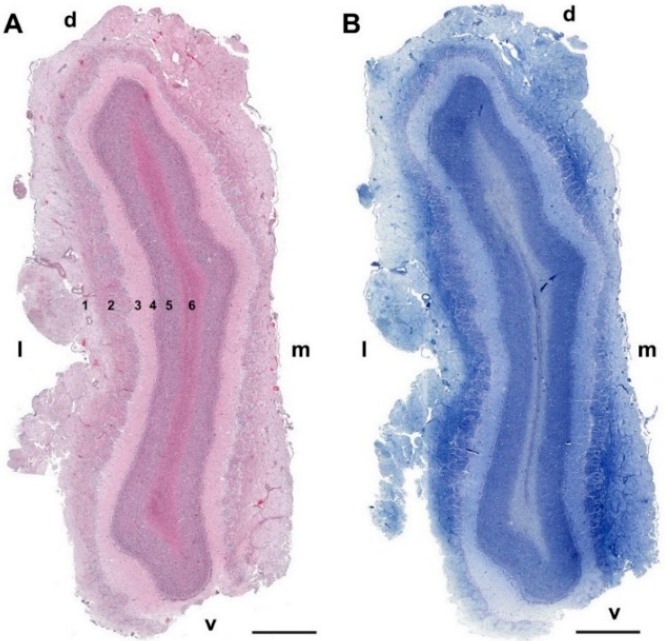
Figure 10. Transverse section of the olfactory bulb of the wolf stained by hematoxylin–eosin ( A ) and Nissl staining ( B ). From superficial to deep, the following layers are identified: (1) Olfactory nerve layer (NL); (2) Glomerular layer (GlL); (3) External plexiform layer (EPL); (4) Mitral cell layer (ML); (5) Granular layer (GrL); (6) White matter: d, dorsal; l, lateral; m, medial; v, ventral. Scale bars: 2 mm.